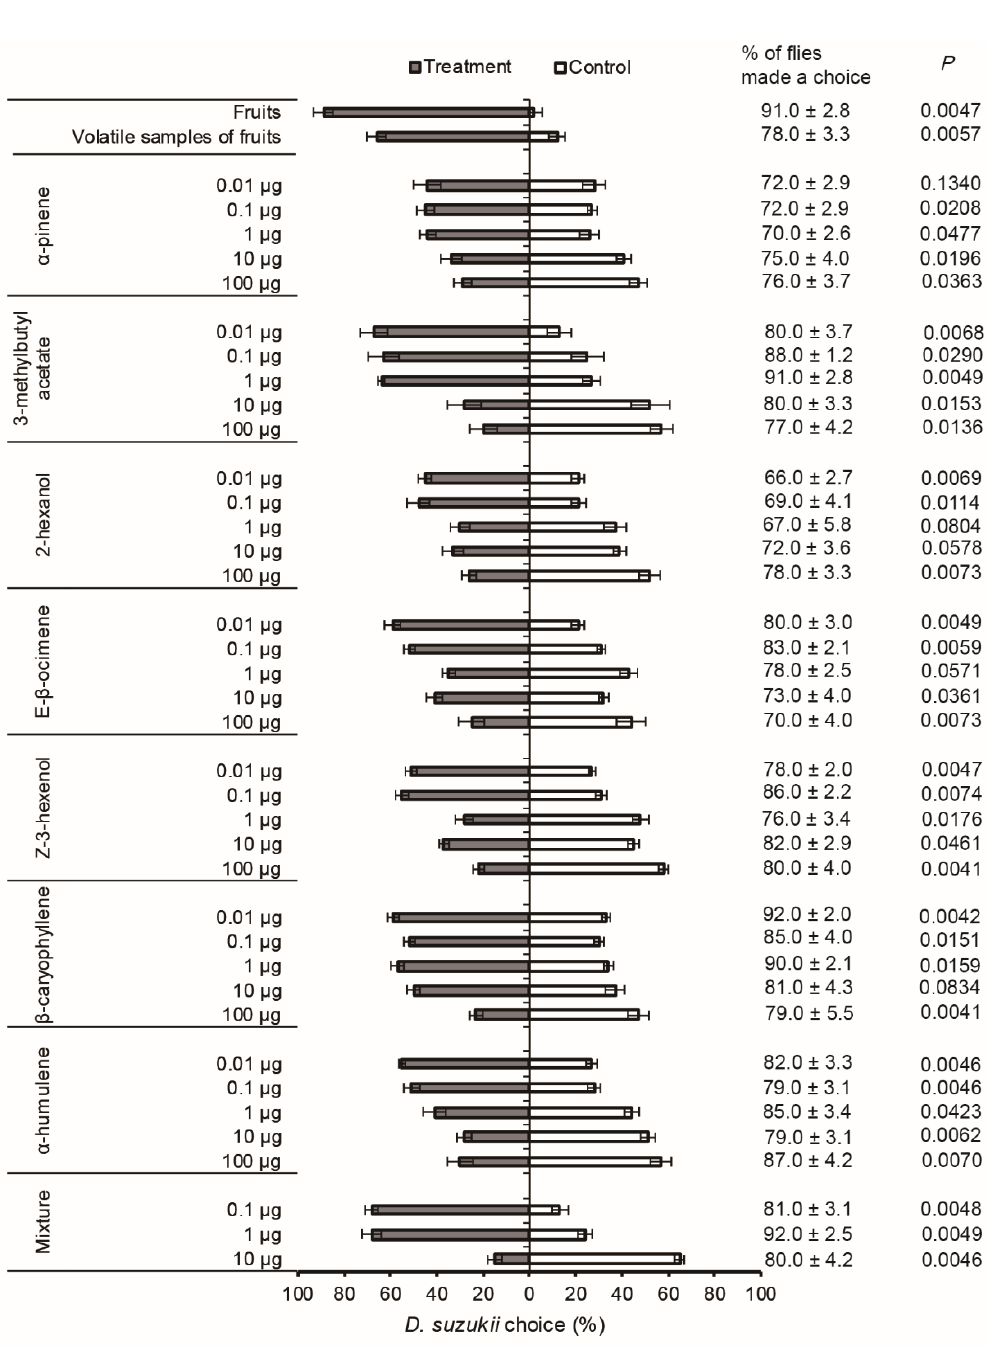
Figure 2. Olfactory responses of female Drosophila suzukii to Osyris wightiana fruits, the headspace volatile sample from fruits, individual EAD-active compounds and their mixture. N = 100 per treatment. The p value was calculated according to Wilcoxon signed-rank tests at the 0.05 level.